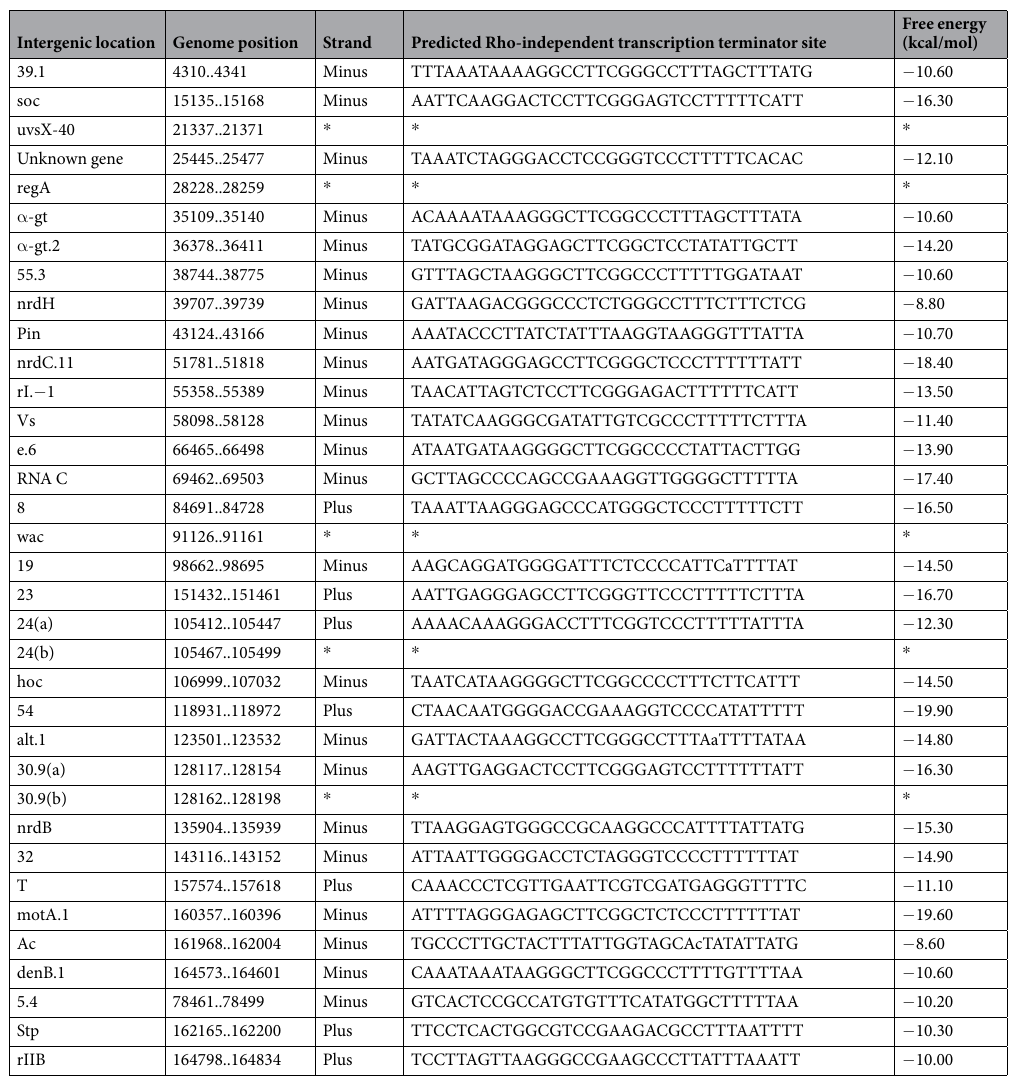
Table-2. Main features of the predicted Rho-independent transcription terminators. The asterisk means that absence of terminator prediction by using Arnold or phiSITE programs.